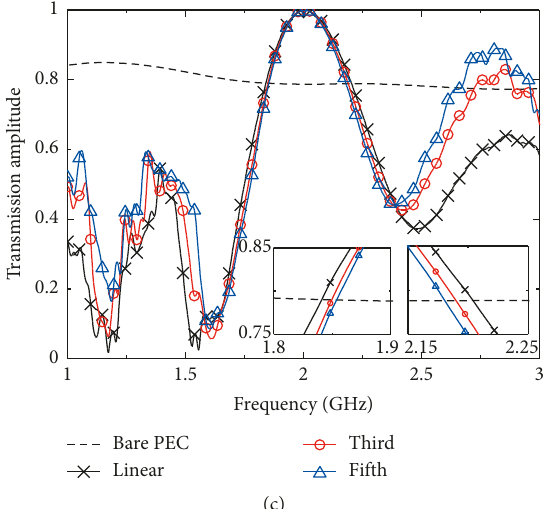
Figure 15: The frequency response of the various functions: (a) the invisibility cloak, (b) the field rotator, and (c) the field concentrator. The insets show the bandwidth characteristics